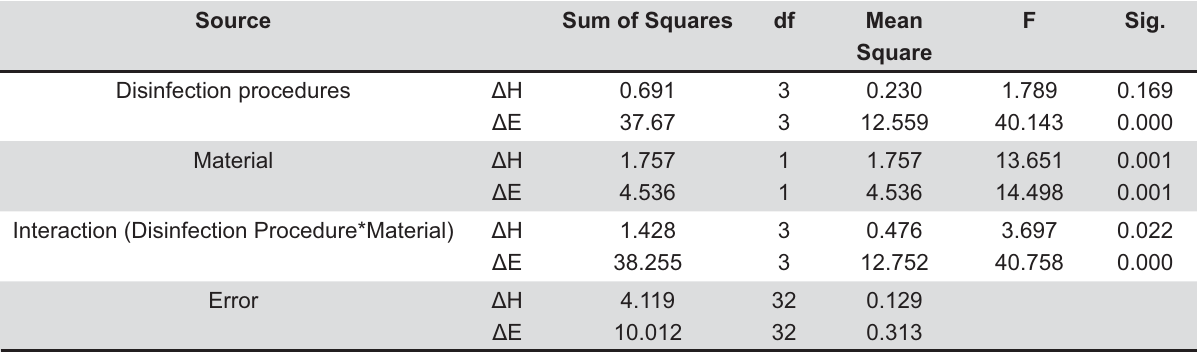
Table 2- (cid:5)(cid:2)(cid:4)(cid:5)(cid:24)(cid:20)(cid:10)(cid:12)(cid:5)(cid:17)(cid:10)(cid:13)(cid:21)(cid:20)(cid:14)(cid:5)(cid:10)(cid:12)(cid:23)(cid:5)(cid:14)(cid:22)(cid:10)(cid:12)(cid:23)(cid:10)(cid:18)(cid:23)(cid:5)(cid:23)(cid:20)(cid:17)(cid:15)(cid:10)(cid:22)(cid:15)(cid:8)(cid:12)(cid:14)(cid:5)(cid:16)(cid:8)(cid:18)(cid:5)(cid:24)(cid:10)(cid:22)(cid:20)(cid:18)(cid:15)(cid:10)(cid:13)(cid:5)#(cid:5)(cid:10)(cid:12)(cid:23)(cid:5)$(cid:5)(cid:10)(cid:16)(cid:22)(cid:20)(cid:18)(cid:5)(cid:22)(cid:30)(cid:20)(cid:5)(cid:23)(cid:15)(cid:16)(cid:16)(cid:20)(cid:18)(cid:20)(cid:12)(cid:22)(cid:5)(cid:23)(cid:15)(cid:14)(cid:15)(cid:12)(cid:16)(cid:20)(cid:19)(cid:22)(cid:15)(cid:8)(cid:12)(cid:5)(cid:31)(cid:18)(cid:8)(cid:19)(cid:20)(cid:23)(cid:21)(cid:18)(cid:20)(cid:14)(cid:5)(cid:10)(cid:12)(cid:23)(cid:5) Tukey's multiple comparisons results, Disinfection procedures